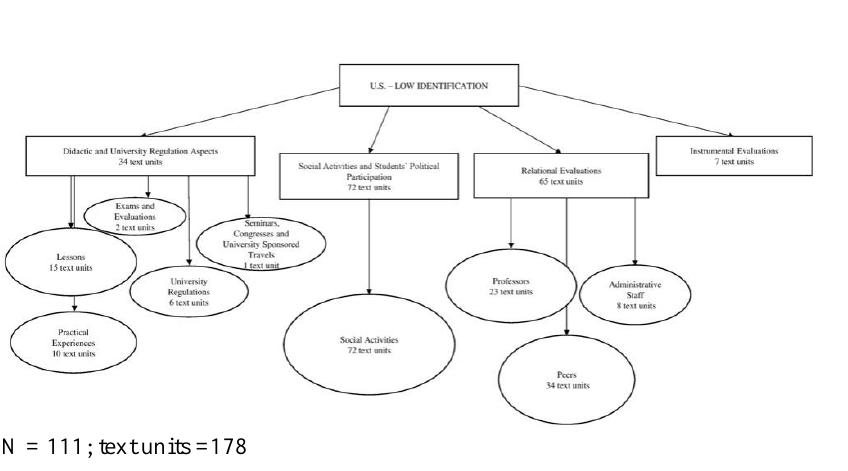
Concept map concerning U.S. students in the condition of low identification